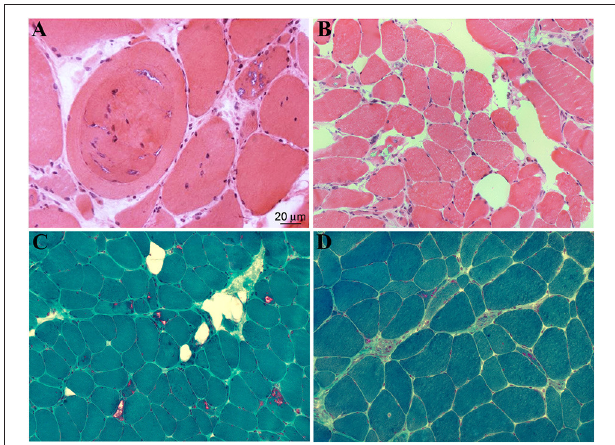
FIGURE 4 | Histopathological features of muscle biopsies from DNAJB6-mutated patients. H&E (A,B) and Gomori trichrome stains (C,D) reveal several autophagic vacuoles, visible either in subsarcolemmal regions or centrally located, internalized myonuclei as well as variability in fiber sizes (Ruggieri et al.,